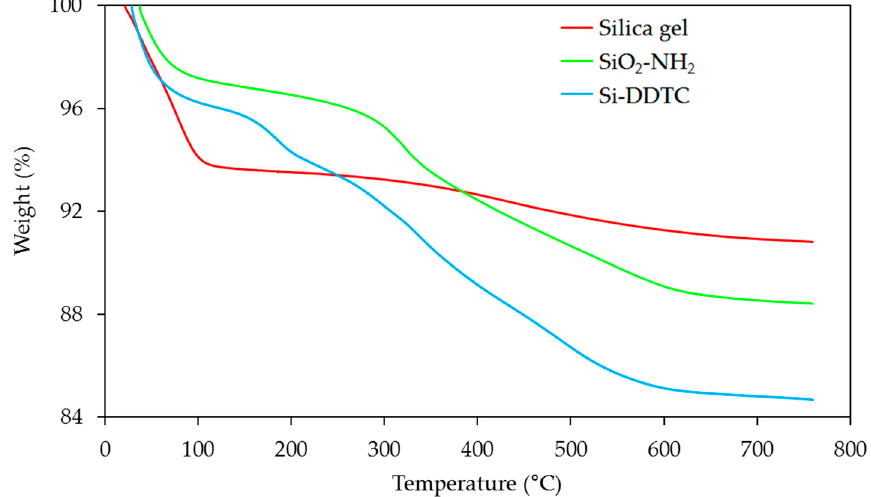
Figure 2. TGA curves of: (red) silica gel, (green) SiO 2 -NH 2 , and (blue) Si-DTC. The PZC for silica gel was 6.0; for the Si-DTC a pH = 8.6 was obtained (Figure 3).